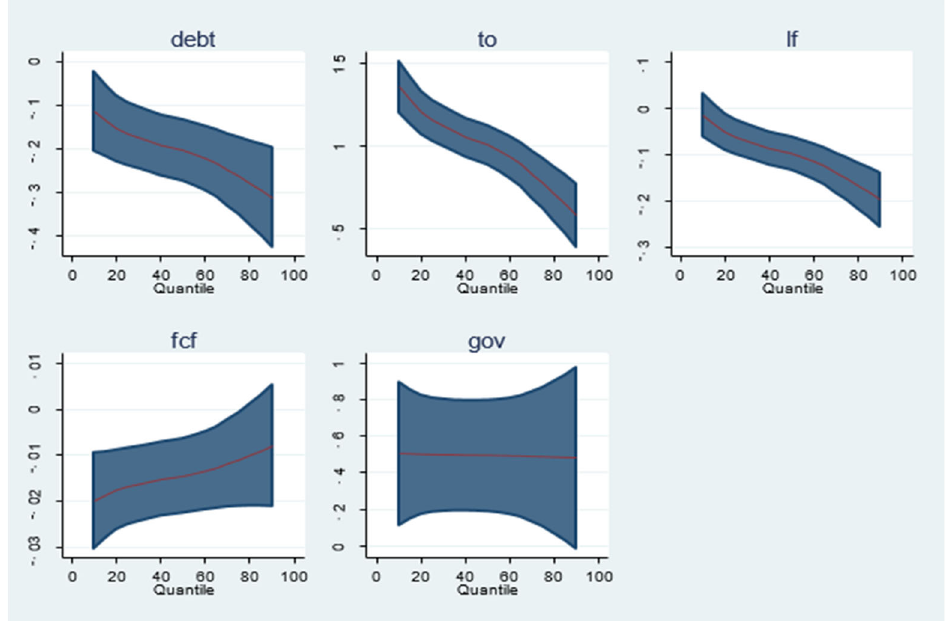
Figure 2. The impact of governance on growth under different quantiles.